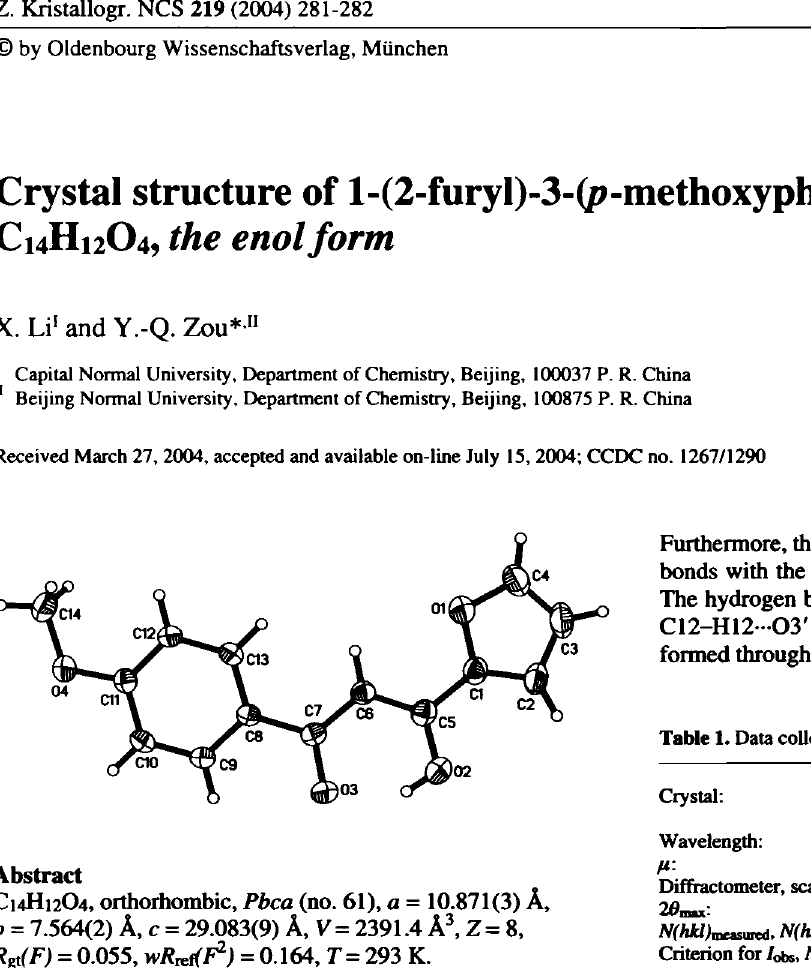
Table 1. Data collection and handling.